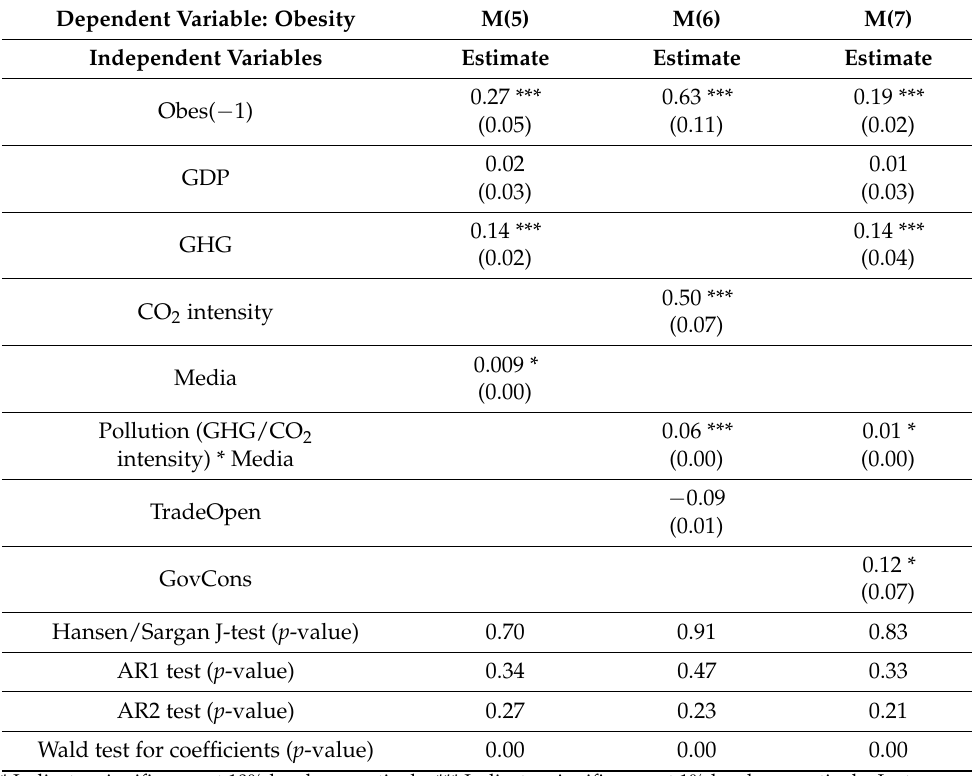
Table 7. Robustness checks: effect of alternative mix of control variables on obesity. Results from one-step system-GMM dynamic panel